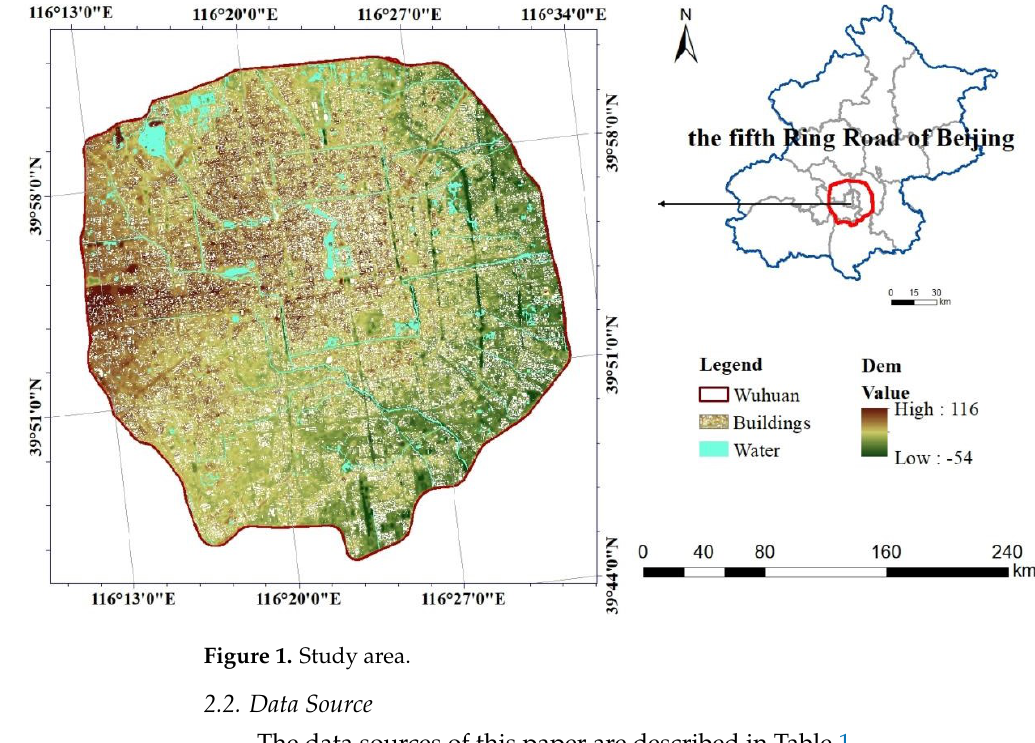
Figure 1. Study area.